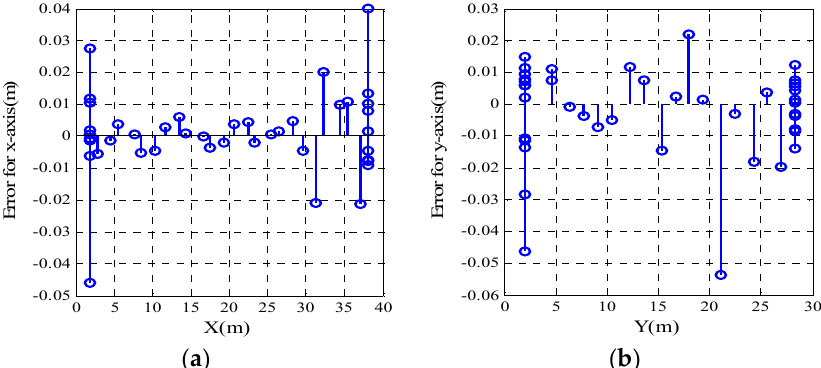
Figure 19. Elderly fall location errors at LOS environments for the ( a ) x-axis and ( b ) y-axis .